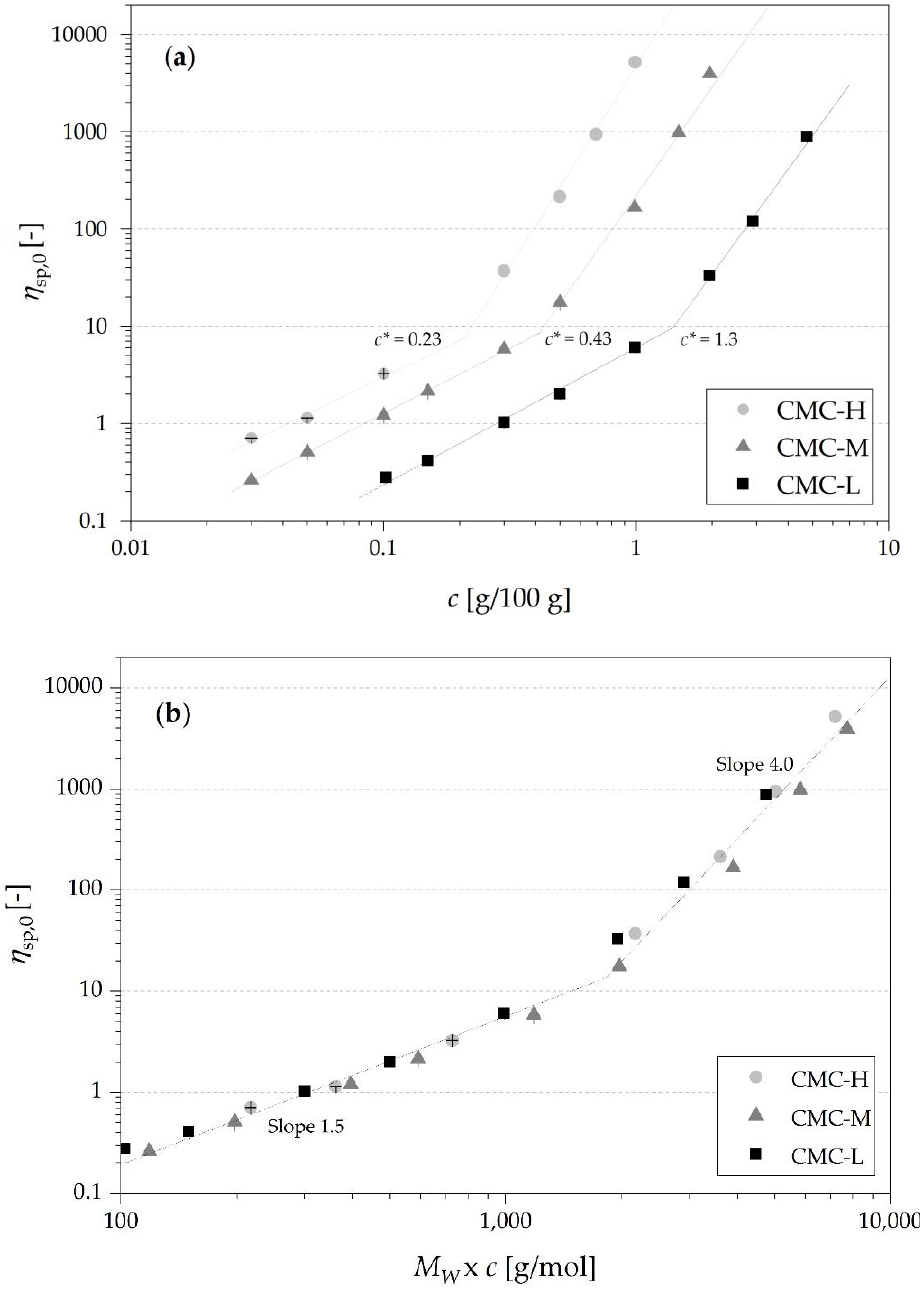
Figure 3. Double logarithmic plot of zero shear specific viscosity against concentration c ( a ) and against the product of c and M W ( b ) of three types of CMCs with different M W : CMC-L (100 kDa), CMC-M (395 kDa), CMC-H (725 kDa). Data in the diluted regions and the concentrated regions were both fitted using a power law equation (R 2 ≥ 0.95).